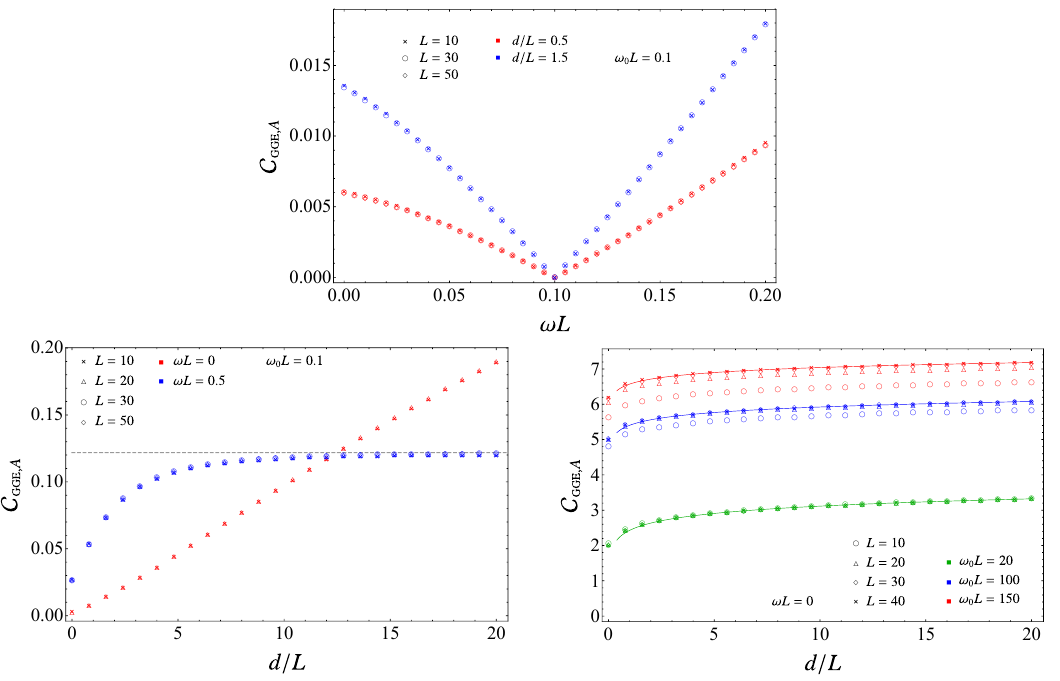
Figure 18 . Asymptotic value of C in (5.26) for a block made by L consecutive sites and GGE ,A separated by d sites from the origin of a semi-infinite line with DBC, in terms of ωL (top panel) and of d/L (bottom